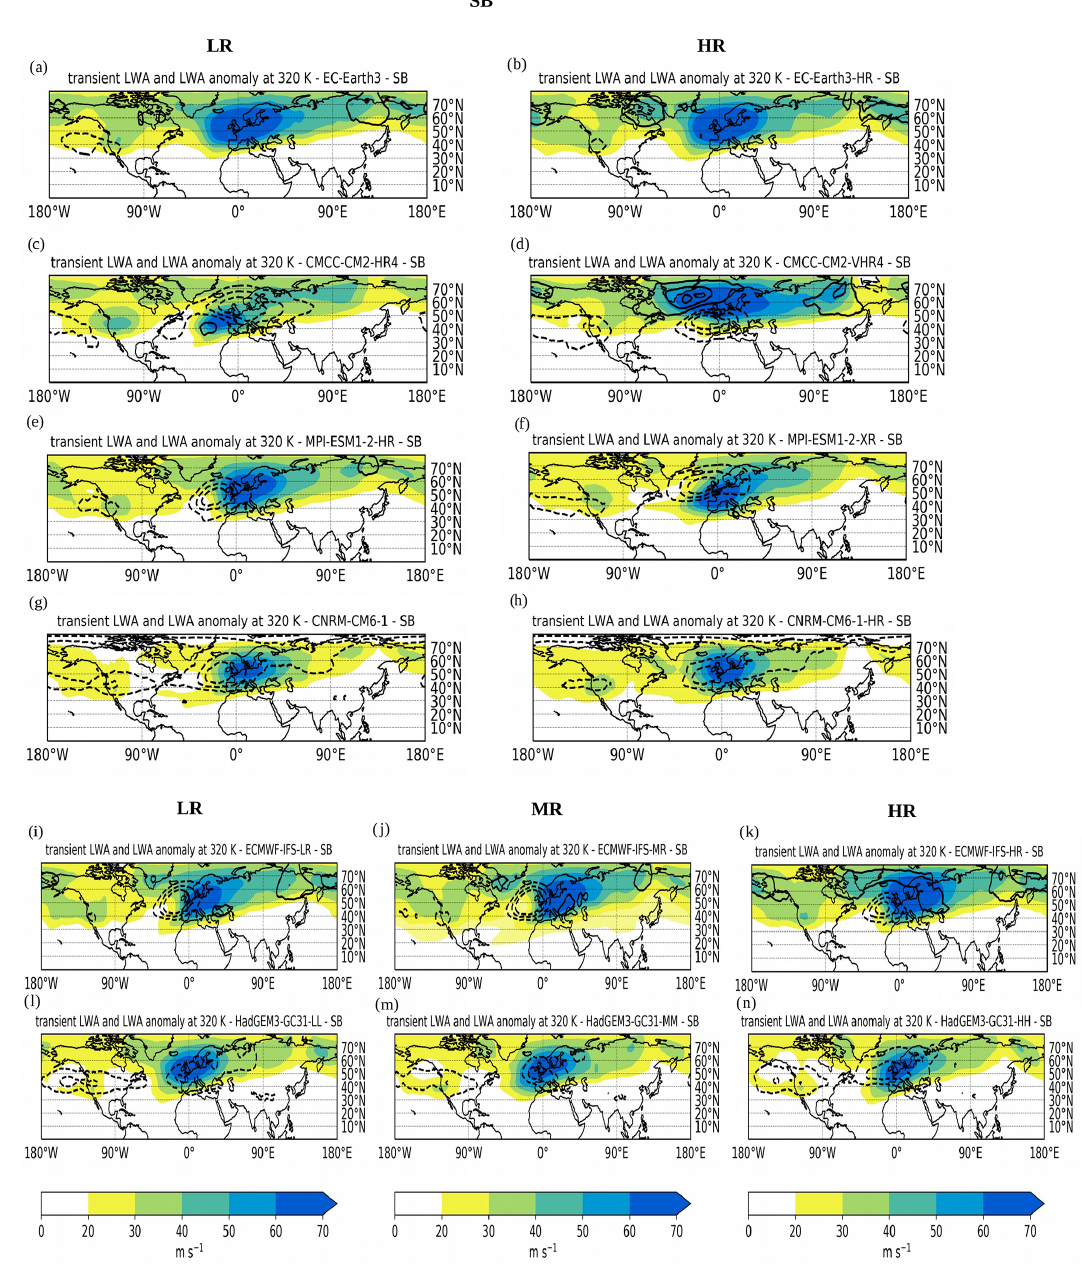
Figure 9. As in Fig. 8 but for